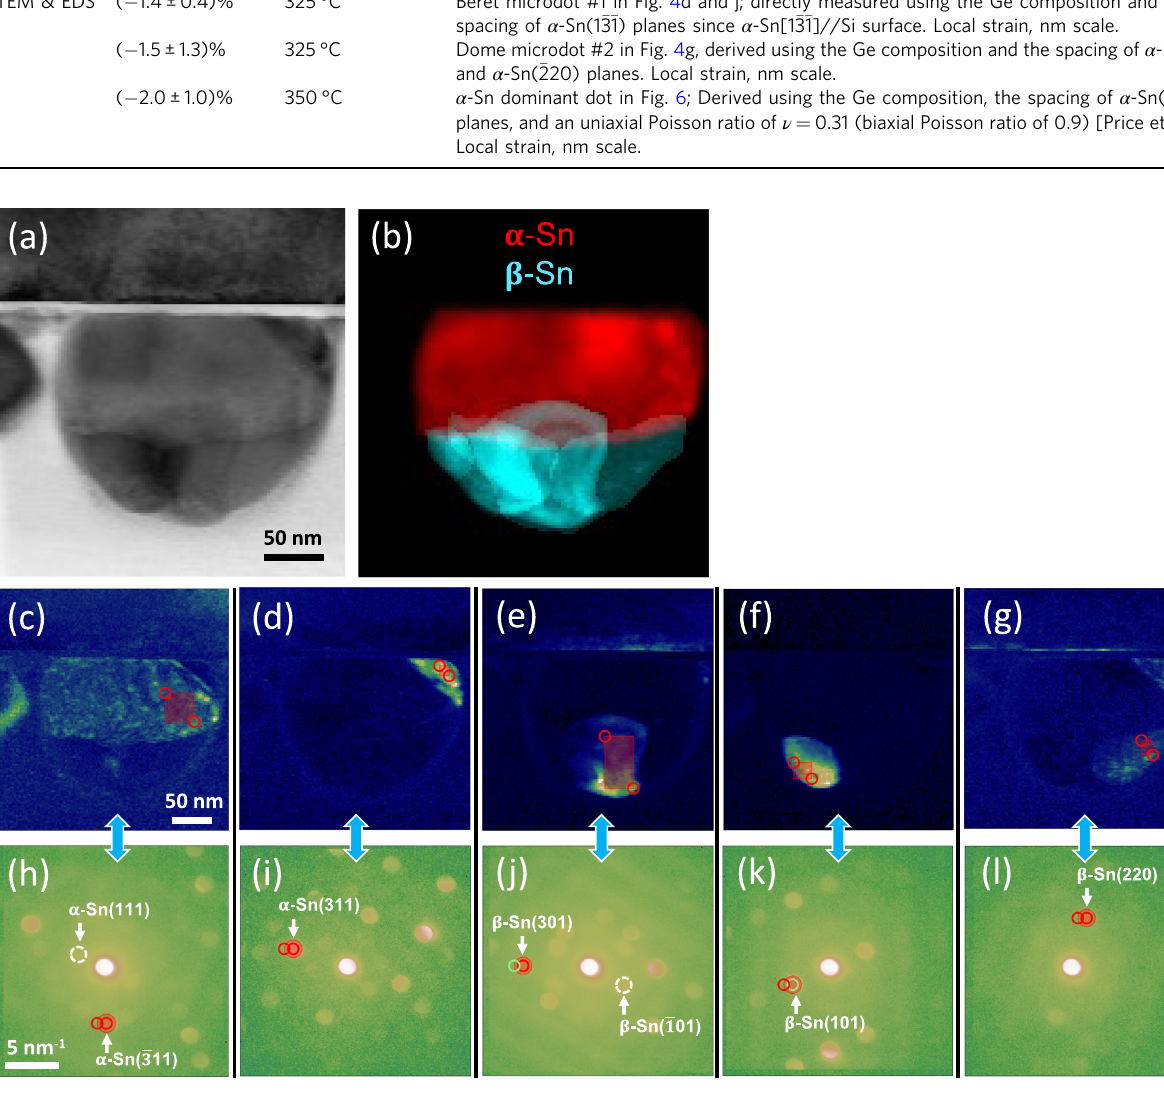
Fig. 5 4D-STEM generated images of a SnGe microdot annealed at 325 °C. a Bright- fi eld image obtained by masking only the (0,0,0) disk for the convergent-beam electron diffraction (CBED) patterns at each pixel. b Phase map showing the spatial distribution of the alpha and beta phases, produced by indexing the diffracted disks and thereby identifying the dominant phase at each pixel. c – g are example dark- fi eld images generated from the corresponding indexed disks (shown as red circles) in h – l (these CBED patterns were generated from various locations over the nanodot as indicated by red rectangles in c – g